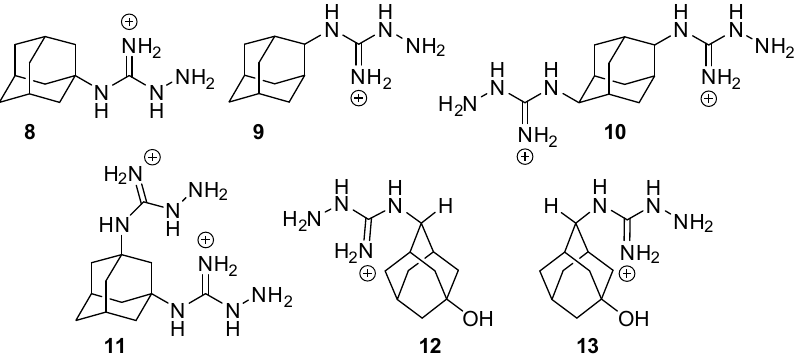
Figure 4. Structures of adamantyl aminoguanidines incorporated into liposomes [32].